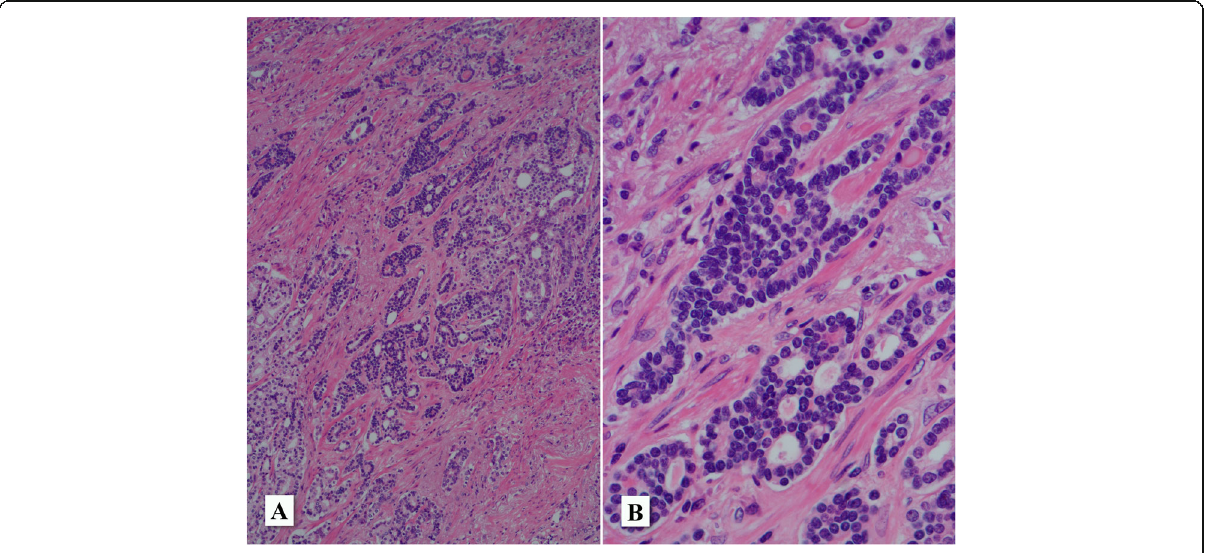
Fig. 3 Small cell-like change in invasive prostatic adenocarcinoma. Hematoxylin and eosin stain: A (100x) and B (400x)